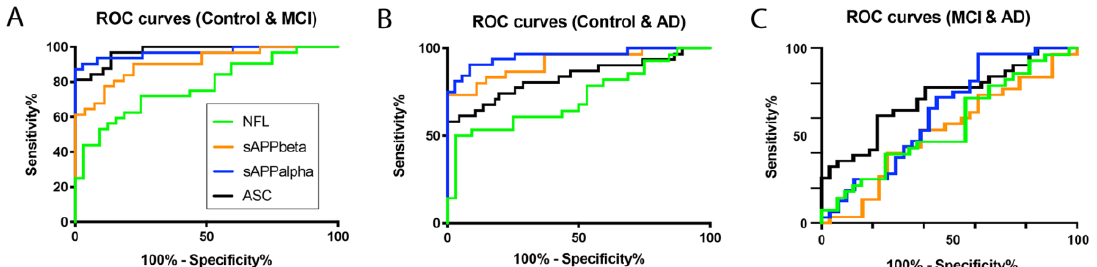
Figure 2. Soluble amyloid precursor proteins (APP) (α and β) and neurofilament light chains were elevated in the serum of MCI and AD patients compared to the control. Protein levels in pg/mL for ( A ) sAPPα, ( B ) sAPPβ and ( C ) neurofilament light (NfL). Soluble (s)APPα: n = 35 control, 31 MCI and 32 AD. sAPPβ: n = 27 control, 31 MCI and 30 AD. NfL: n = 32 control, 32 MCI and 28 AD. Box and whiskers are shown for the 5th and 95th percentiles.